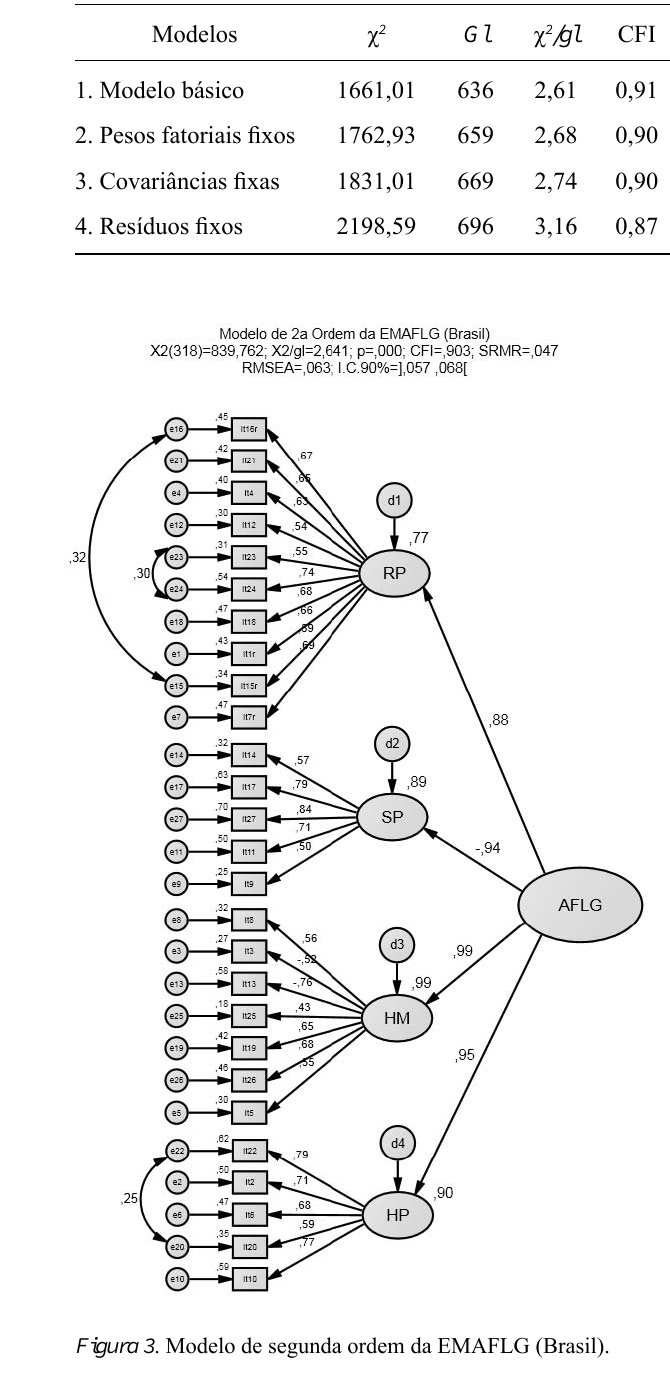
Figura 3 . Modelo de segunda ordem da EMAFLG